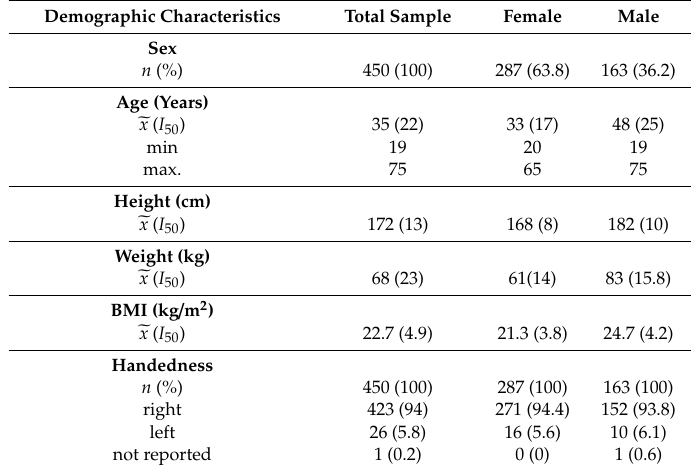
Table 2. Demographic characteristics of all participants with a total sample size of n = 450.